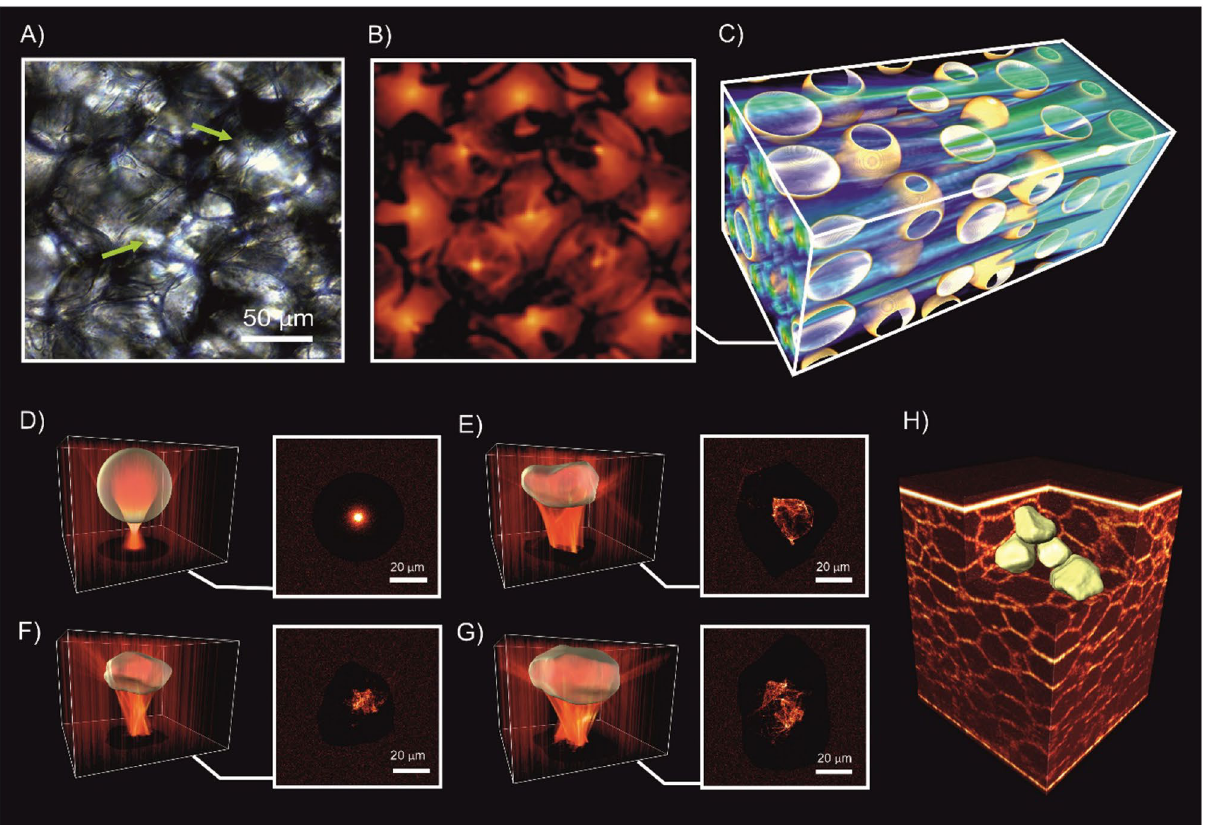
Figure 1. Multiplexed spatially-focused localization of light in adipose biological tissues observed experimentally ( A ), and obtained computationally ( B ) and ( C ) utilizing an idealized shape of spherical adipocytes ( D ). The shapes of individual adipocytes ( F,G ) confirmed and evaluated by the direct visualization of the porcine tissue by using optical coherence tomography ( H